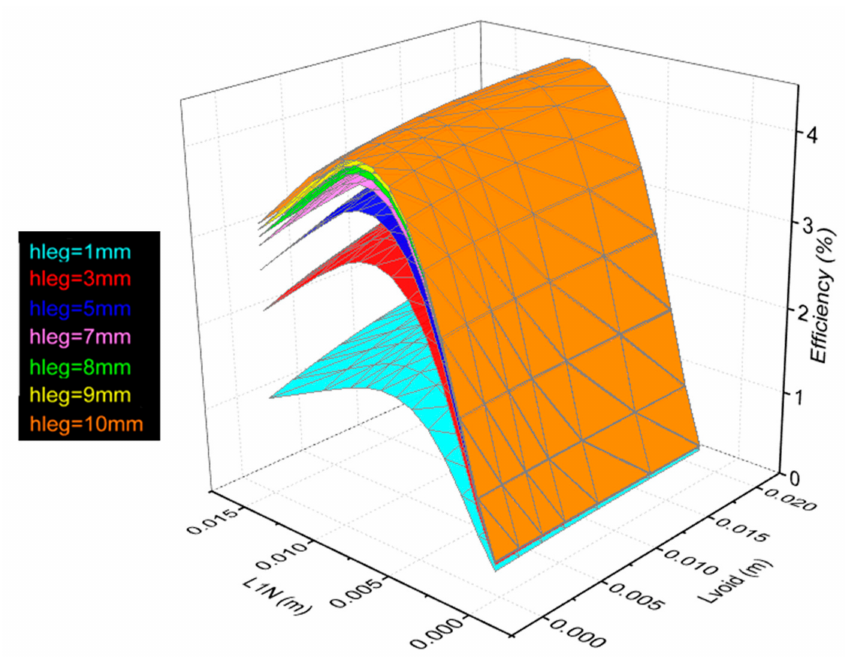
Figure 18. Efficiency as a function of n-type diameter, L 1 N , and element spacing, L void , for several element thicknesses, h leg